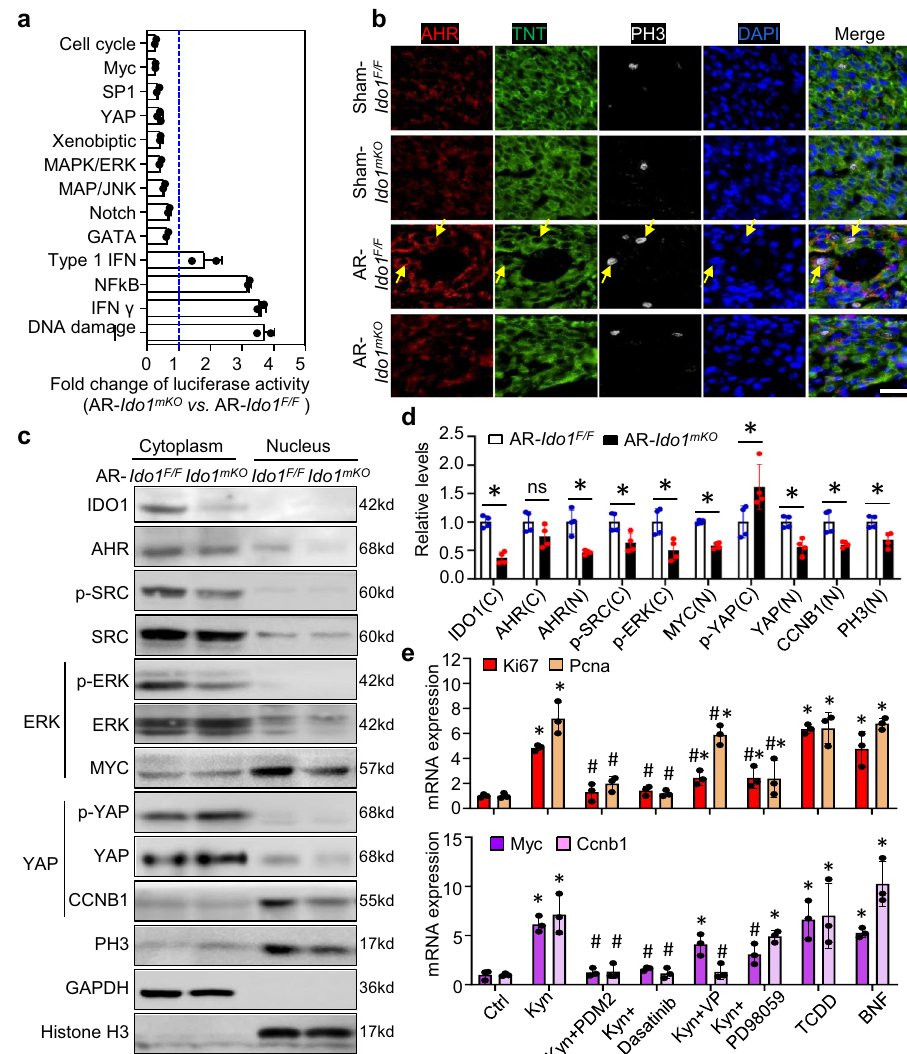
Fig. 3 | The cytoplasmic IDO1-Kyn-AHR-YAP/ERK pathway promotes cardio- myocyte(CM)proliferation. Ido1 F/F ( Ido1 Flox/Flox )and Ido1 mKO ( Tnt Cre ; Ido1 Flox/Flox )mice underwentheartARorShamsurgeryatP1andwerecollectedatP3forprimaryCM isolation and analysis. a A 45 Cignal fi nder multi-pathway reporter array showed signi fi cant changes in signaling activities in primary AR- Ido1 mKO CMs versus AR- Ido1 F/F CMs. The statistical test used the unpaired two-tailed t test between two groups. n =3 biologically independent samples for the YPA pathway and n =2 for other pathways. b Co-immuno fl uorescence staining showed the cytoplasmic location of AHR in CMs (yellow arrow), and PH3 expression in AHR-positive cells